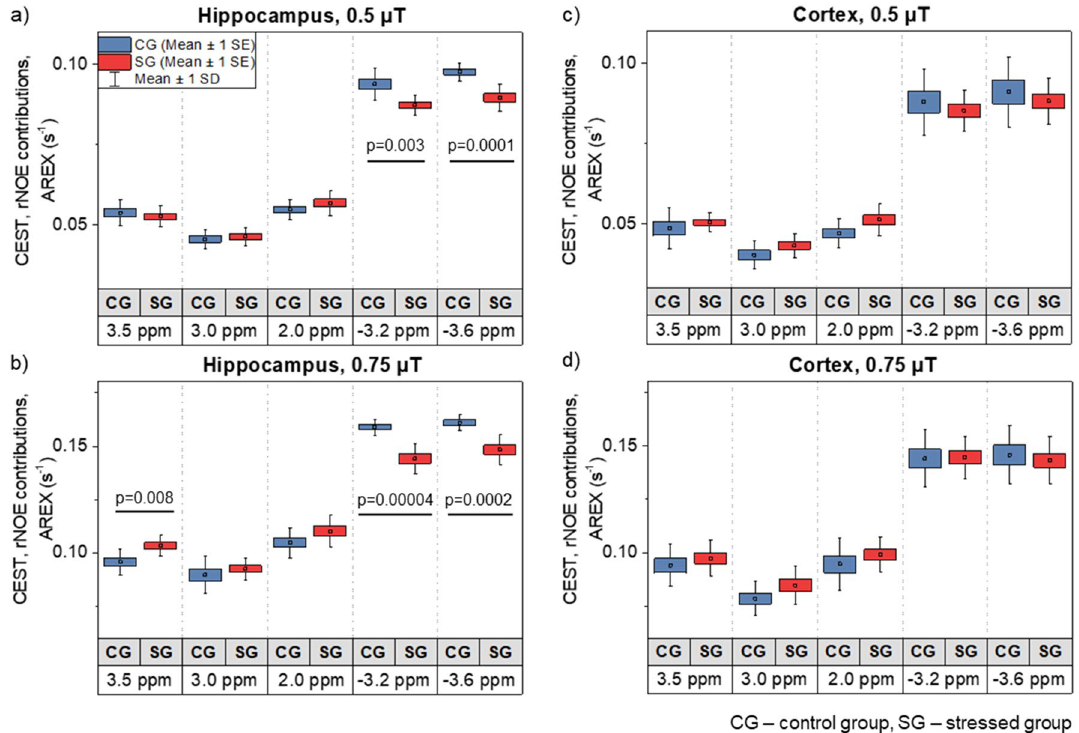
Figure 5. Comparison of the CEST and rNOE contributions after any T 1 effect was eliminated between the control and stressed groups with saturation B 1 of 0.5 µT and 0.75 µT in the ( a , b ) hippocampus and ( c , d ) cortex. In the hippocampus, stress-induced changes associated with the 3.5 ppm amide offset and − 3.2 and − 3.6 ppm aliphatic offsets were significant whereas, in the cortex, there were no significant differences between groups of animals in any of the chosen offsets. Statistically significant results are denoted by p-values derived from two- tailed Student’s